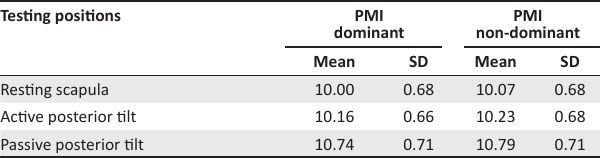
PMI dominant non-dominant SD SD